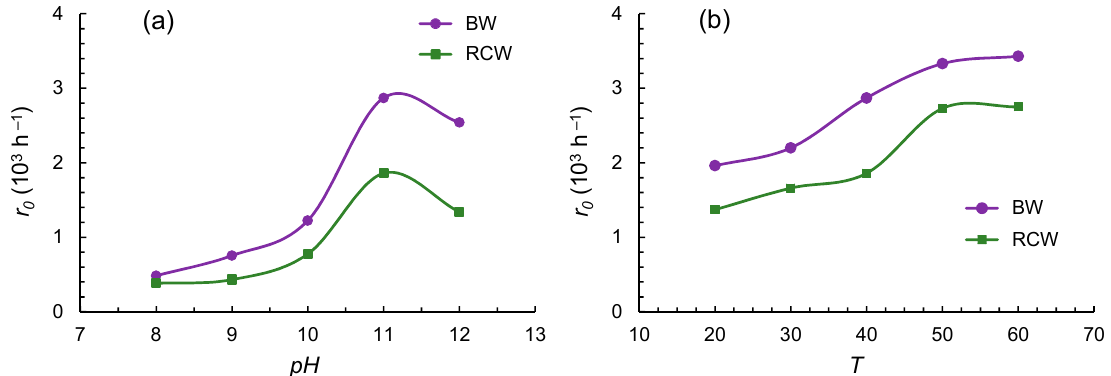
Figure 5. Effect of: ( a ) pH at T = 40 °C and ( b ) temperature at pH = 11 on the initial rates ( r 0 ) of nanoparticle production from bilberry waste (BW) and red currant waste (RCW) extracts. Figure 4. Effect of temperature on the SPR band of Ag-NPs obtained from bilberry waste (BW) and red currant waste (RCW) (other conditions: pH = 11; Reaction time = 5 h; Silver-to-polyphenol ratio = 10 mol Ag + /mol GAE).